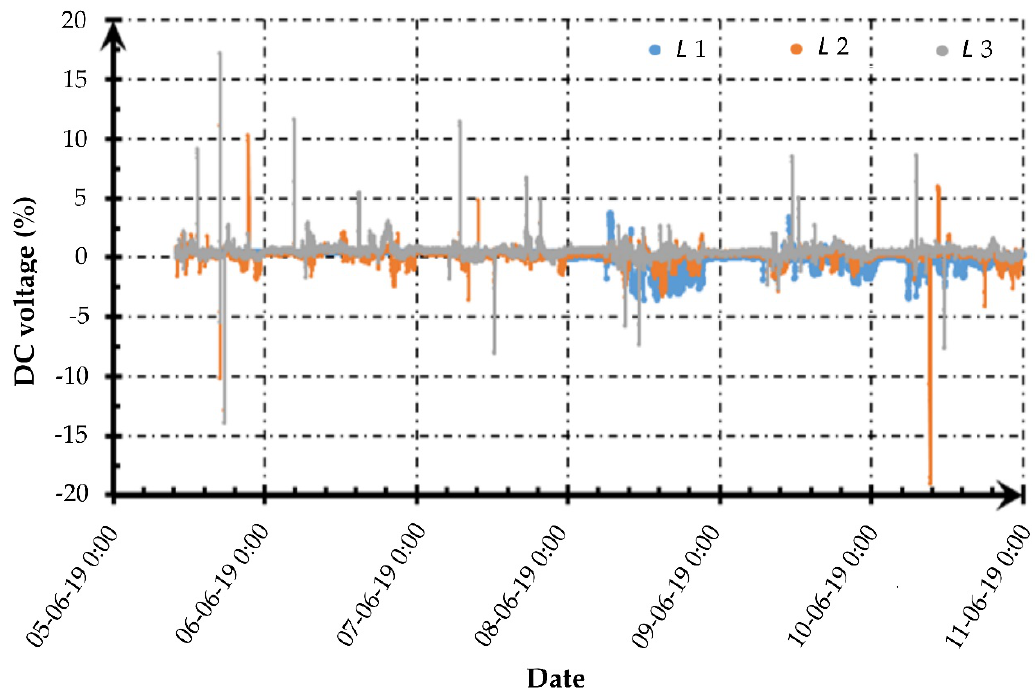
Figure 8. Constant component (DC) in voltage.